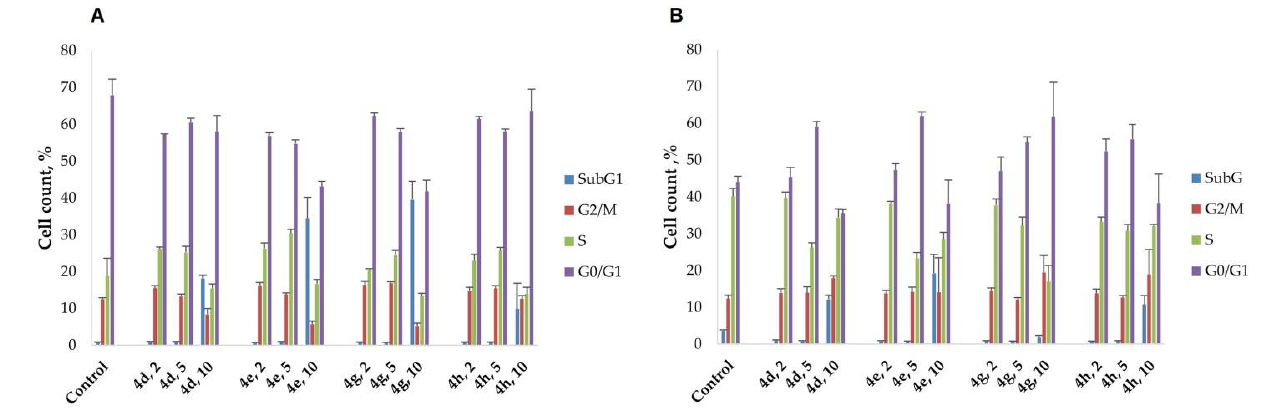
Figure 9. Effect of cycloadducts 4c–i at concentration 10 μg/mL on the distribution of CT26 cells in the cell cycle.